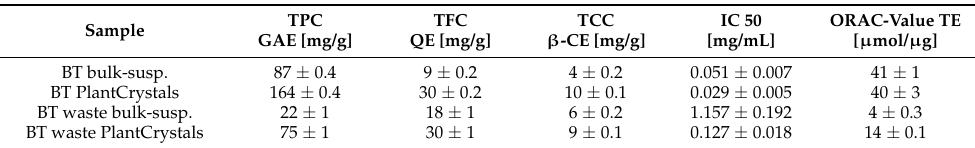
Table 3. A comparison between content and antioxidant capacity (AOC) measurements of the produced PlantCrystals from black tea (BT) and its waste with their corresponding bulk suspensions. Total polyphenol content (TPC) is expressed in gallic acid equivalents (GAE), total flavonoid content (TFC) is expressed in quercetin equivalents (QE), total carotenoid content (TCC) is expressed in β -carotene equivalents ( β -CE), IC 50 is giving the amount of active constituents needed to scavenge 50% of a given amount of free radicals and ORAC-values are expressed in Trolox equivalents (TE). Sample TPC GAE [mg/g] TFC QE [mg/g] TCC β -CE [mg/g] IC 50 [mg/mL] ORAC-Value TE [ µ mol/ µ g] BT bulk-susp. 87 ± 0.4 9 ± 0.2 4 ± 0.2 0.051 ± 0.007 41 ± 1 BT PlantCrystals 164 ± 0.4 30 ± 0.2 10 ± 0.1 0.029 ± 0.005 40 ± 3 BT waste bulk-susp. 22 ± 1 18 ± 1 6 ± 0.2 1.157 ± 0.192 4 ± 0.3 BT waste PlantCrystals 75 ± 1 30 ± 1 9 ± 0.1 0.127 ± 0.018 14 ±